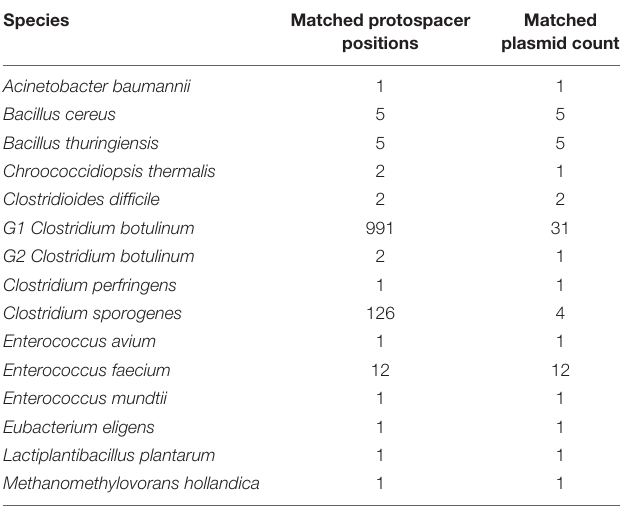
TABLE 1 | Count of RefSeq plasmids and protospacer loci by species matched to spacers from the 241 strain G1 C. botulinum and C. sporogenes dataset. Species Matched protospacer